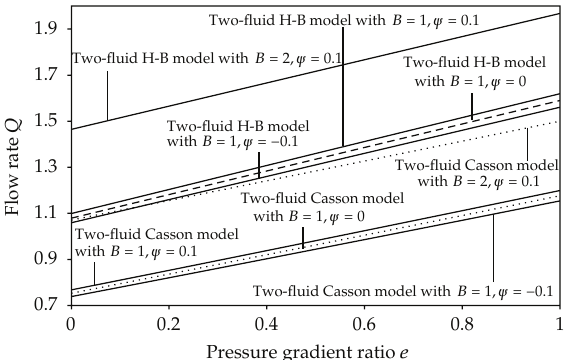
Figure 7: Variation of flow arte with pressure gradient for two-fluid H-B and Casson models and di ff erent values of B and ψ with t (cid:7) 45 ◦ , b (cid:7) 0 . 1, β (cid:7) n (cid:7) 0 . 95, δ P (cid:7) θ (cid:7) 0 . 1, ω (cid:7) 1, φ (cid:7) α H (cid:7) α C (cid:7) 0 . 2, and z (cid:7) 2 .